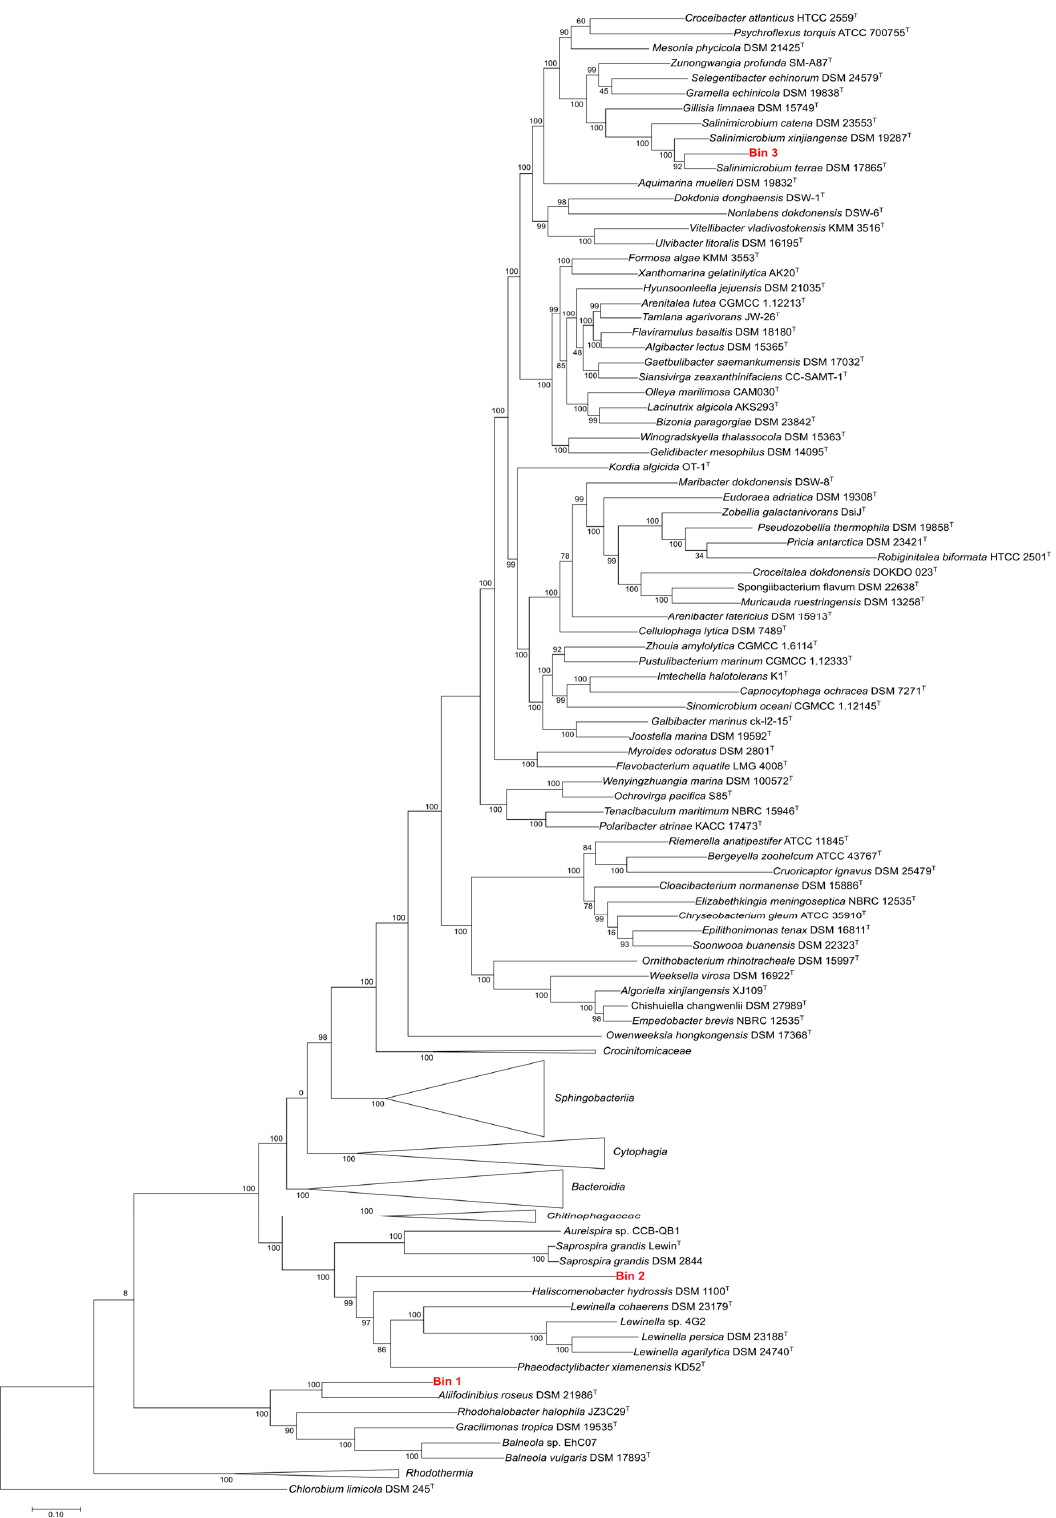
Figure 5. Genome phylogeny of the phylum Bacteroidetes using PhyloSift v1.0.1 marker genes [52]. The branch length units are substitutions per site and node labels are clade confidence estimates. Bins assembled in this study are marked in red. Chlorobium limicola DSM 245 T was used as outgroup. See Materials and Methods sections for further methodological details.